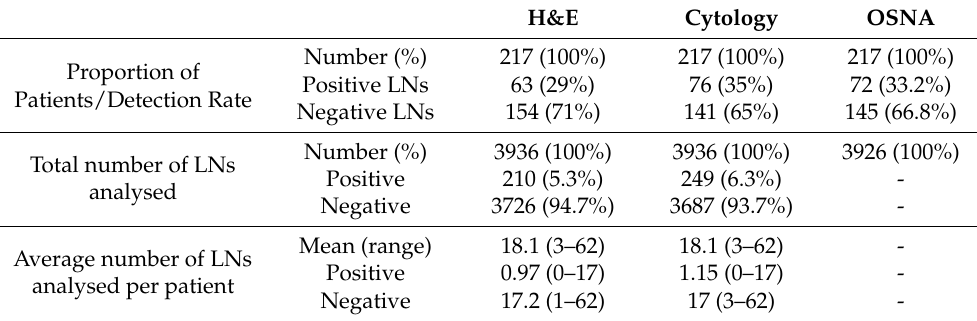
Figure 3. Forest plot displaying the positive detection rate, or proportion of patients with positive lymph nodes, of the three methods of LN analysis. H&E: haematoxylin and eosin; OSNA: one-step nucleic acid amplification. Table 2. Comparison of the number of positive LN detected by the three